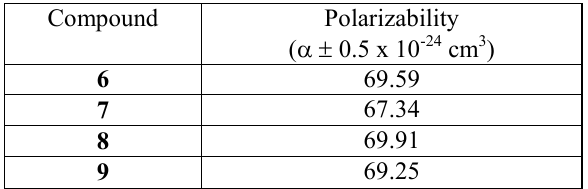
Table 2. Polarizability (calculated value) for compounds